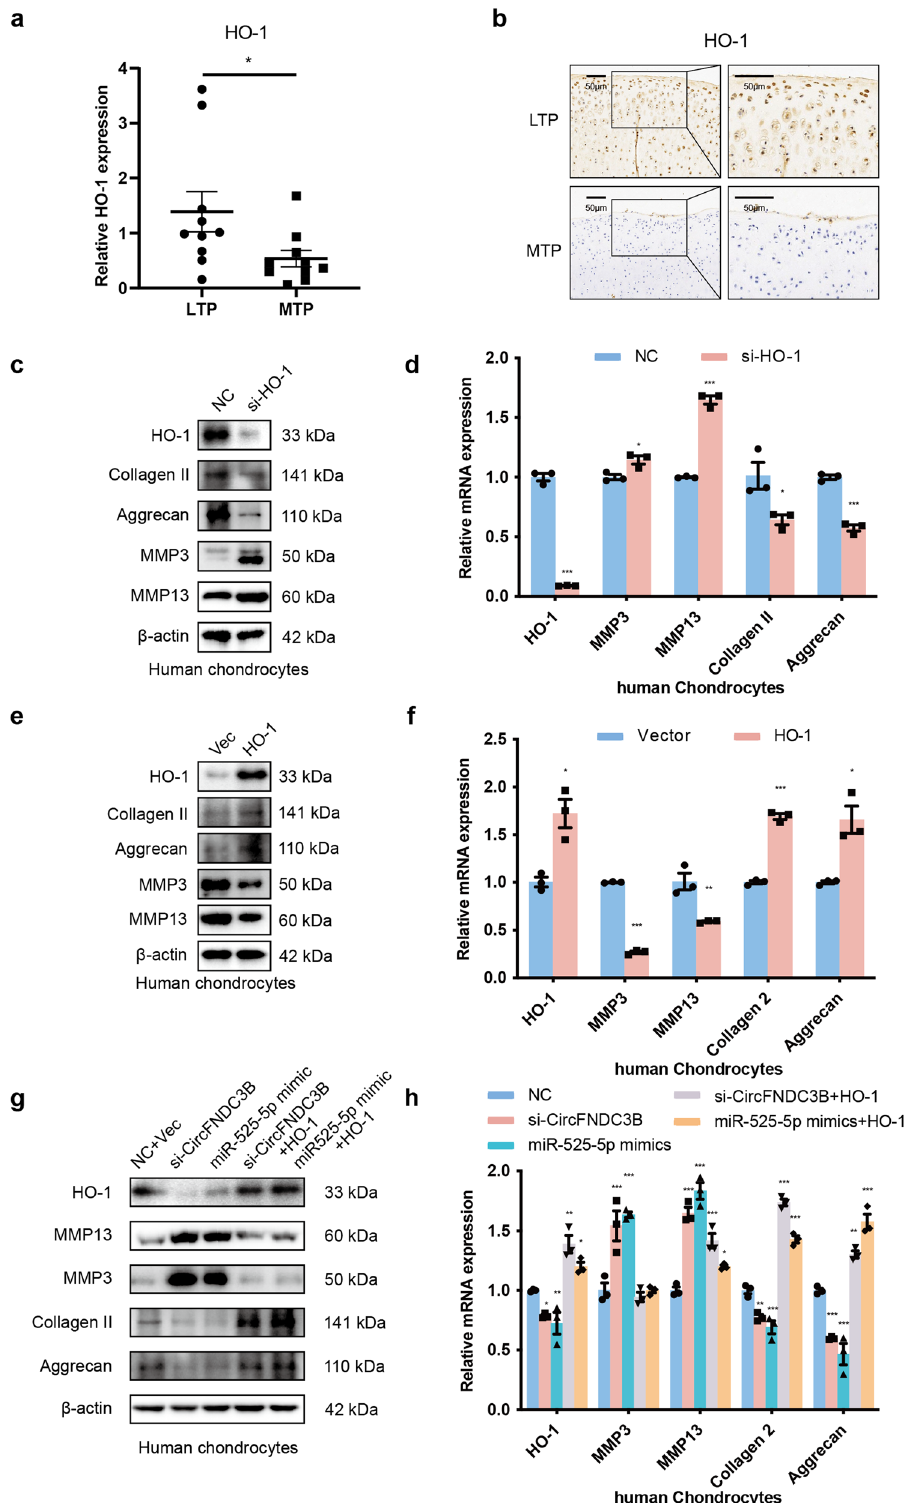
Fig. 7 HO-1 is down-regulated in OA tissue and con fi rmed as the downstream gene for CircFNDC3B and miR-525-5p. a RT-qPCR analysis of HO-1 in different stress areas of 10 human cartilage samples. ( n = 10). b Representative images of immunohistochemistry staining of HO-1 in MTP and LTP. Scale bar, 50 µ m. c , d Western blot and RT-PCR analysis of HO-1, MMP3, MMP13, Collagen II, and Aggrecan when HO-1 was downregulated in HCs. ( n = 3). e , f Western blot and RT-PCR analysis of HO-1, MMP3, MMP13, Collagen II, and Aggrecan when HO-1 was overexpressed in HCs. ( n = 3). g , h Western blot and RT-PCR analysis showed that overexpression of HO-1 could antagonize the effects of si-CircFNDC3B and miR-525-5p mimic on HO-1, MMP3, MMP13, Collagen II, and Aggrecan in HCs. (n = 3). Mean ± SEM; *p < 0.05; **p < 0.01; ***p < 0.001 by Student ’ s t